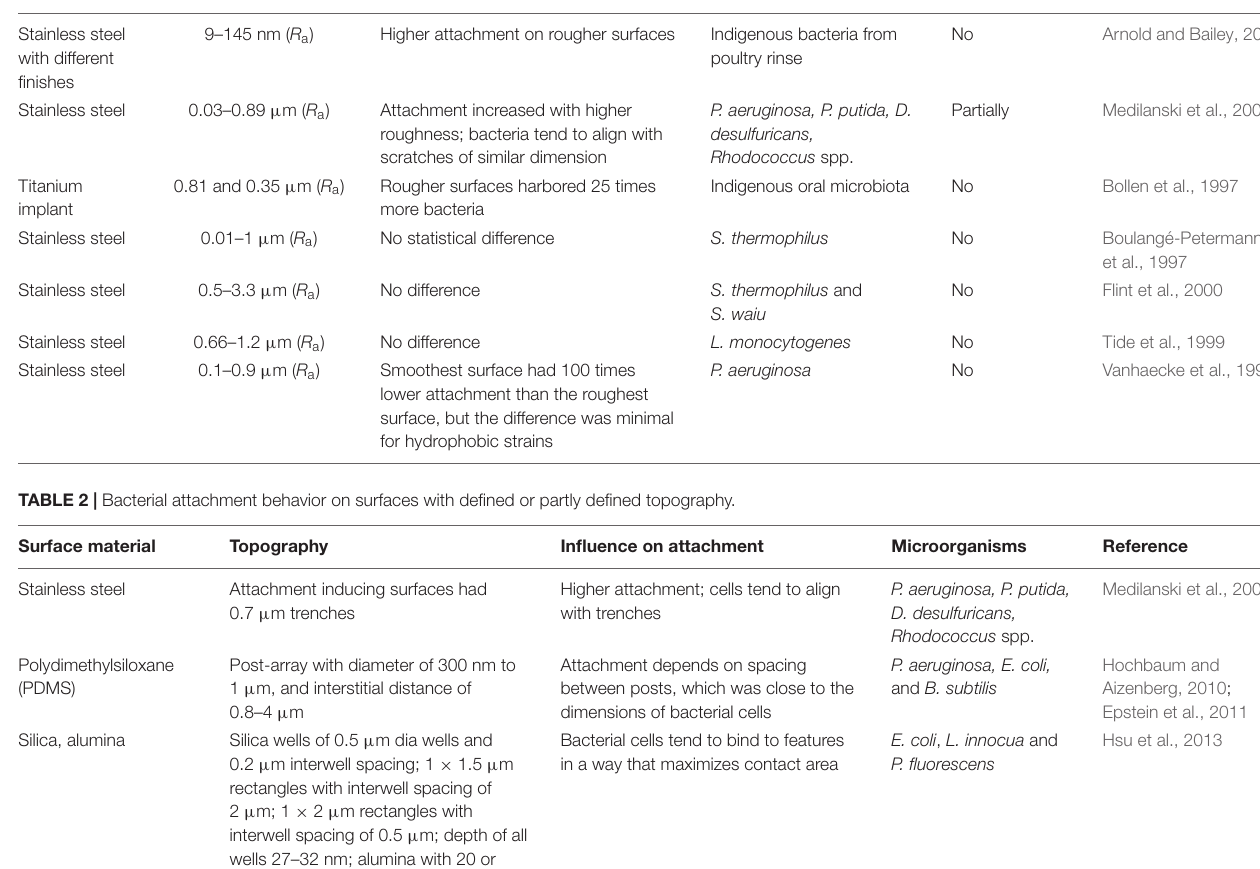
TABLE 1 | Influence of surface roughness on bacterial attachment.